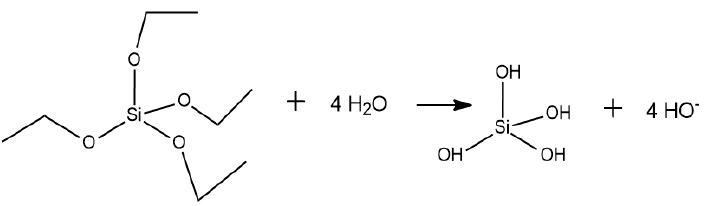
Figure A1. Hydrolysis of TEOS.